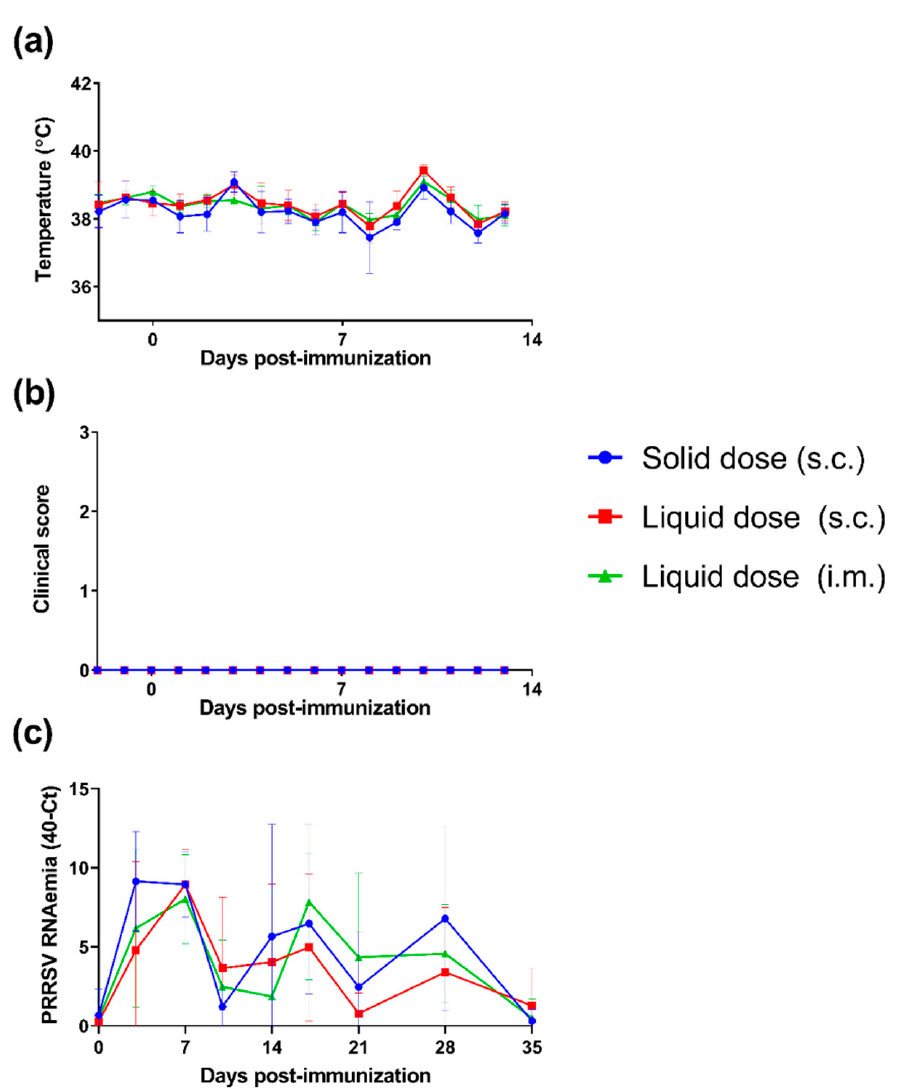
Figure 2. Assessment of clinical signs and viraemia following immunisation of pigs with a unit solid dose injectable formulation of live attenuated PRRSV-1. Three groups of pigs (n = 6) were immunised by s.c. inoculation of a USDI formulation of 10 5 TCID 50 of PRRSV-1 Olot/91, or by s.c. or i.m. inoculation of a comparable dose of PRRSV-1 Olot/91 (s.c. liquid dose and i.m. liquid dose, respectively). ( a ) Rectal temperatures and ( b ) clinical signs were scored daily from -2 to 13 days post-immunisation. ( c ) Levels of PRRSV-1 RNA circulating in blood were assessed by RT-qPCR analysis of longitudinally collected sera. RT-qPCR data are presented as 40—cycle threshold (Ct). Mean data ± SD are shown for each vaccine group.